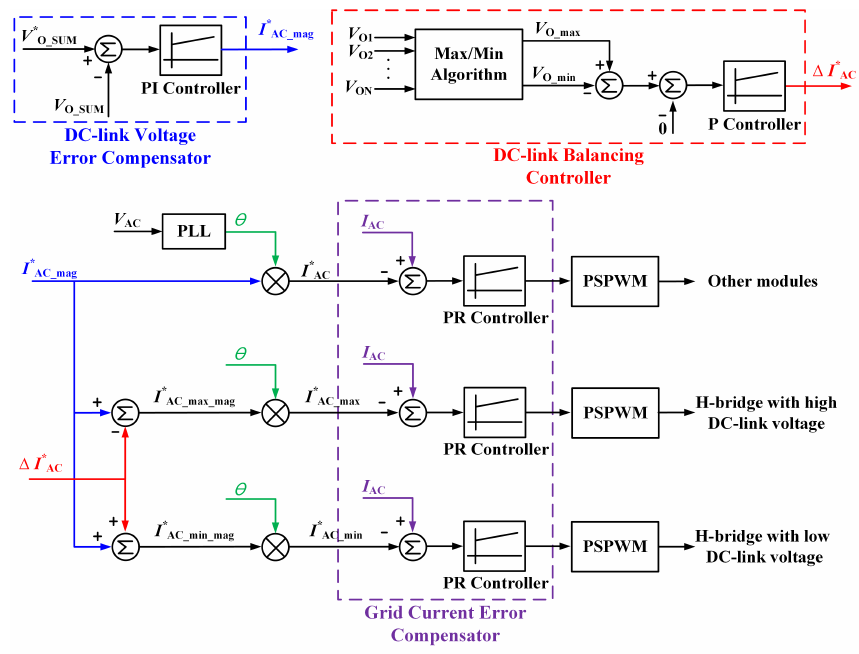
Figure 2. The entire control block diagram for AC/DC